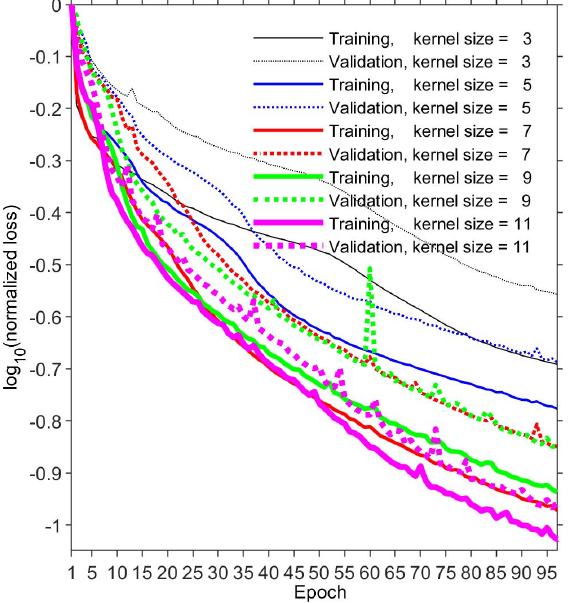
Figure 6. Variation in log (normalized loss) with epoch for 3D CNN’s training (solid curve) and 10 validation (dotted curve) processes using various sizes of the convolutional